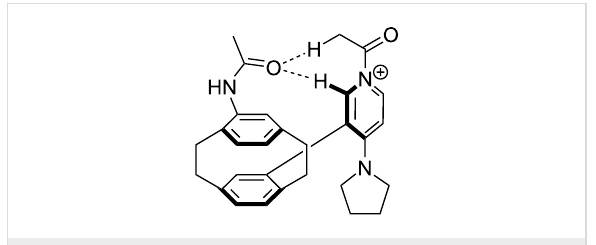
Figure 11: Structure of the acetylated pyridine 380 ( 380Ac ).